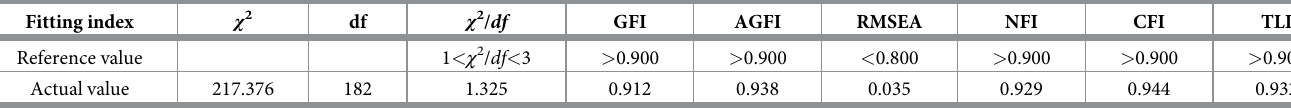
Table 15. Tourist model fitting